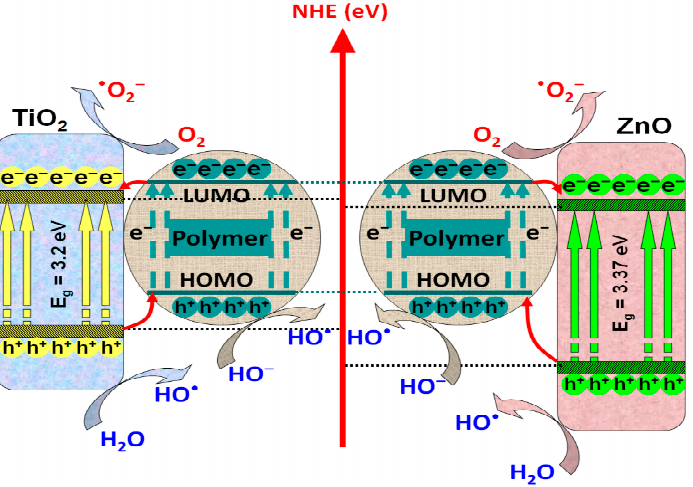
Figure 2. Mechanism of charge photogeneration in polymers/TiO 2 or ZnO composites. Table 1. Polymer/TiO 2 - or ZnO-based composites.